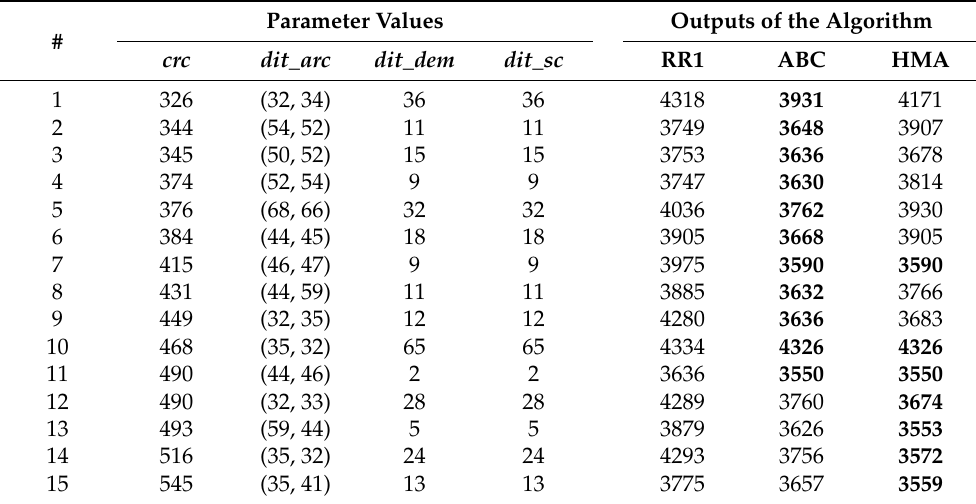
Table 9. The best total costs of 15 independent runs, calculated by the RR1, ABC, and HMA within one minute, after the occurrence of a random demand increased event in the “egl-e1-A” instance.